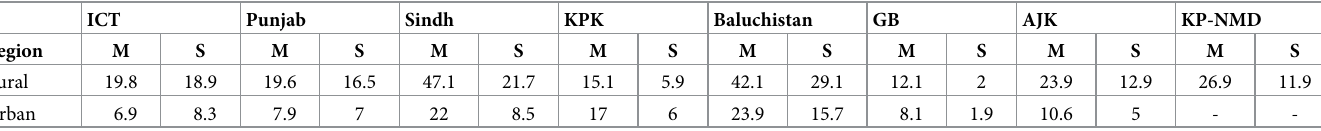
Table 1. Food insecurity in